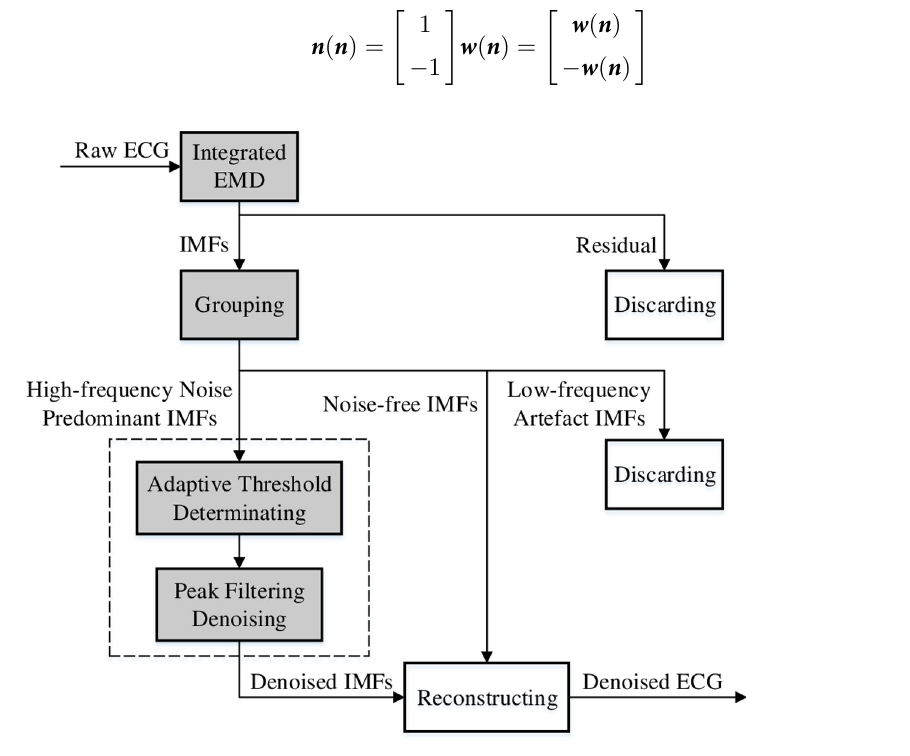
Fig 1. Flow of IEMD-ATD for ECG